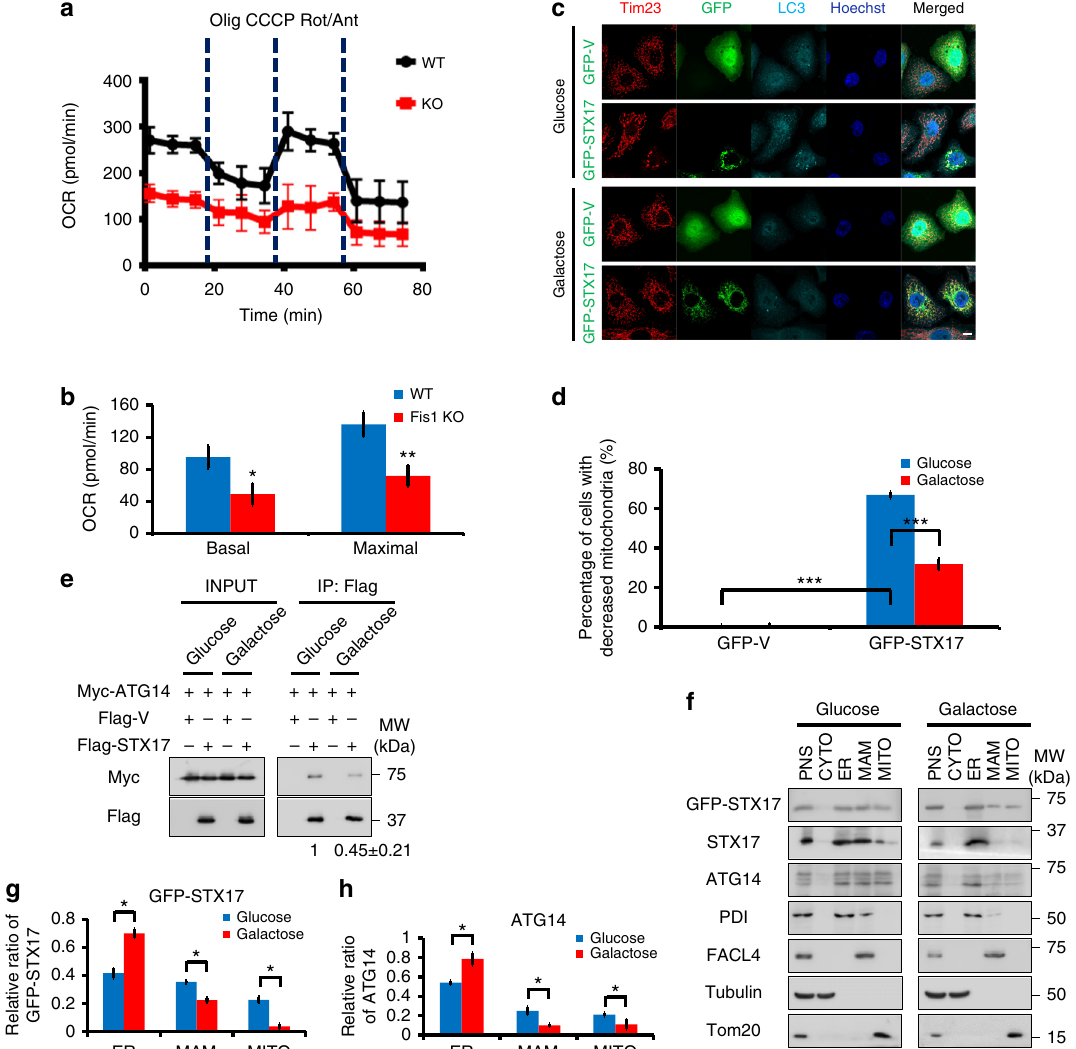
Fig. 8 Mitochondrial fi ssion 1 protein (Fis1) depletion accompanies mitochondrial respiration dysfunction. a Oxygen consumption rate (OCR) was measured in wild-type ( WT ) and Fis1 knockout ( KO ) HeLa cells. Dashed vertical lines indicate the addition of 1 µ M oligomycin (Olig), 0.5 µ M carbonyl cyanide 3-chlorophenylhydrazone (CCCP), and 1 µ M rotenone plus 1 µ M antimycin A (Rot/Ant), respectively ( n = 8). b Individual parameters for basal respiration and maximal respiration analysis of a . ** P < 0.01, * P < 0.05 (two-tailed unpaired Student ’ s t test, n = 3). c Glucose or galactose-cultured Fis1 KO HeLa cells were transiently transfected with green fl uorescent protein (GFP)-tagged vector or syntaxin 17 (STX17) for 24 h. Cells were fi xed and immunostained with anti-Tim23 (red) and anti-LC3 (cyan) antibodies. Hoechst, blue. Scale bar, 10 µ m. d Quanti fi cation of c . *** P < 0.001 (two-tailed unpaired Student ’ s t test). n = 150 GFP-positive cells/group from three replicates. e Plasmids as indicated were transfected into Fis1 KO HeLa cells. At 6 h post-transfection, cells were cultured in medium with glucose or galactose for further 18 h. Cells were extracted and co-immunoprecipitated with anti-Flag beads, followed by immunoblotting with respective antibodies. The fold change of the interaction between ATG14 and STX17 is shown as mean ± SD from three independent experiments. f GFP-tagged STX17 was transfected into Fis1 KO HeLa cells for 6 h. Then, cells were cultured in medium with glucose or galactose for further 18 h. Immunoblotting of subcellular fractions were analyzed. PNS, post-nuclear supernatant; CYTO, cytosol; ER, endoplasmic reticulum; MAM, mitochondria-associated membranes; MITO, mitochondria. g , h Quanti fi cation of relative ratio of GFP-tagged STX17 ( g ) or endogenous ATG14 ( h ) in the respective subcellular fractions. * P < 0.05 (two-tailed unpaired Student ’ s t test, n = 3). Error bars represent SD ( a , b , g and h